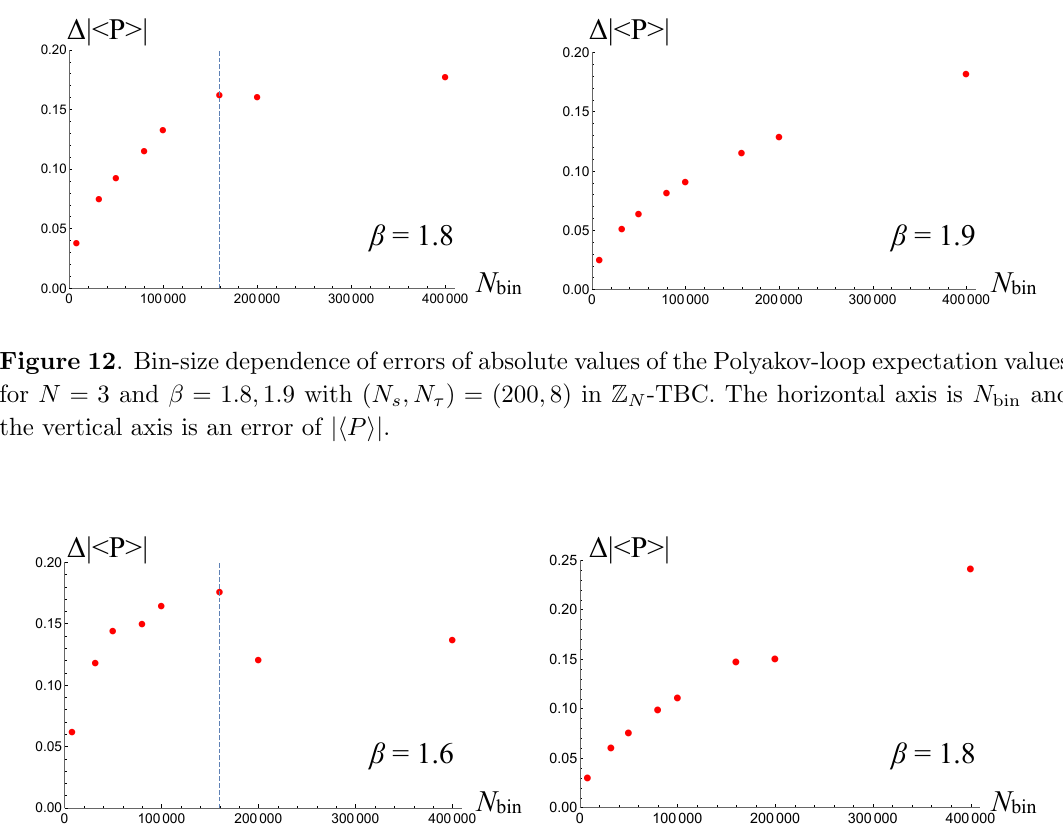
Figure 13 . Bin-size dependence of errors of absolute values of the Polyakov-loop expectation values for N = 5 and (cid:12) = 1 : 6 ; 1 : 8 with ( N s ; N (cid:28) ) = (200 ; 8) in Z N -TBC. The horizontal axis is N bin and the vertical axis is an error of jh P ij